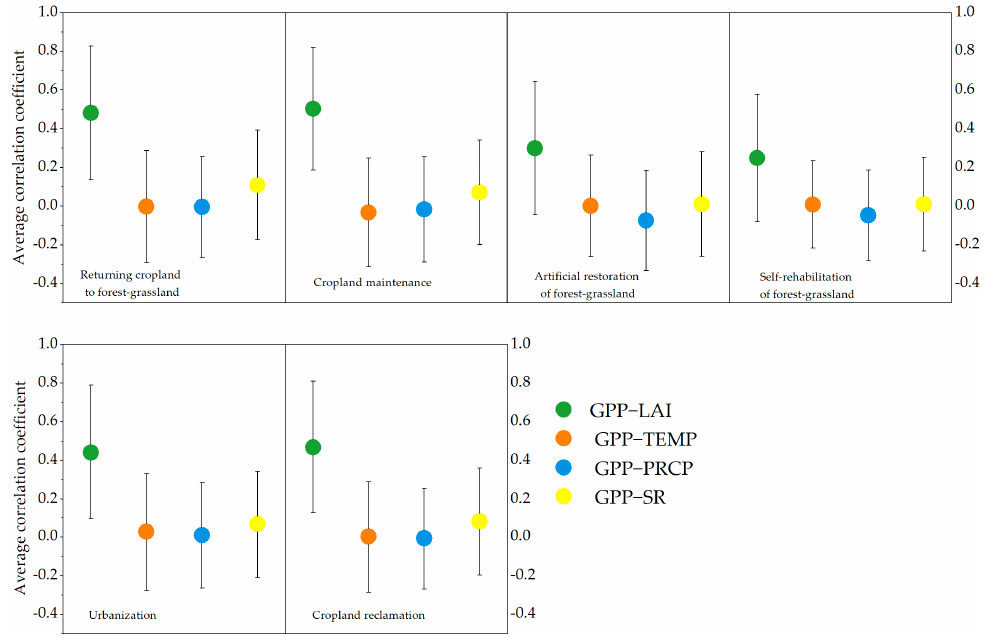
Figure 12. Average correlation coefficients and standard deviations of the GPP with LAI, TEMP, PRCP, and SR correlations in different main land cover change types.